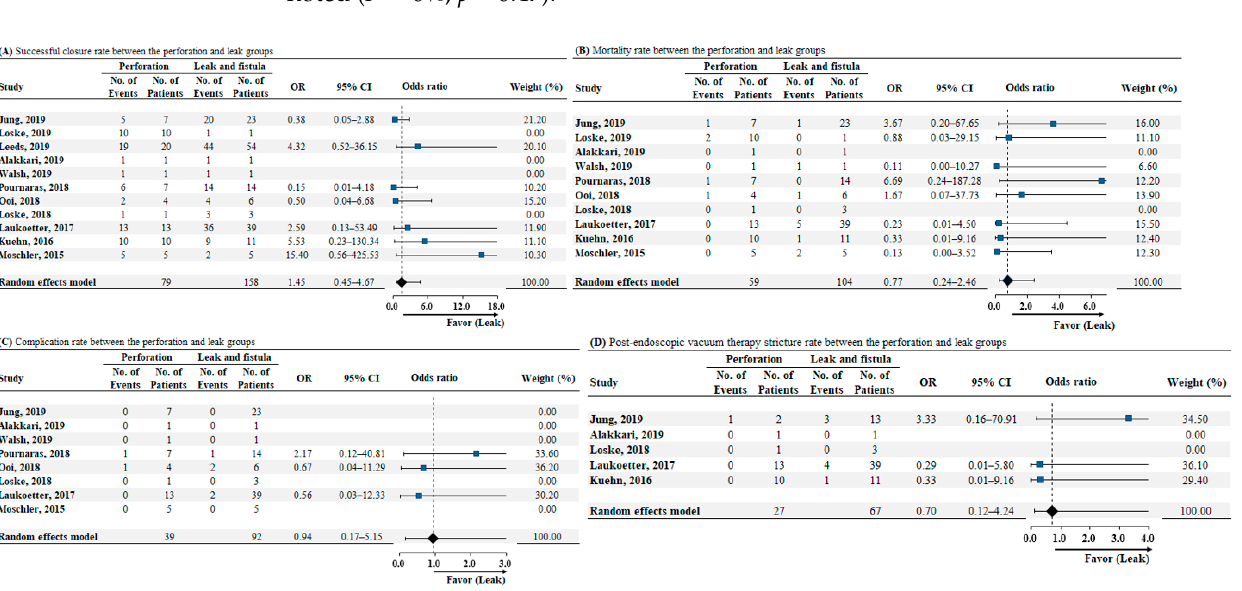
Figure 4. ( A ) Forrest plot of successful closure rate for comparison between the perforation and leak group. ( B ) Forrest plot of mortality rate for comparison between perforation and leak groups. ( C ) Forrest plot of complication rate for comparison between perforation and leak groups. ( D ) Forrest plot of postendoscopic vacuum therapy stricture rate for comparison between perforation and leak groups. Abbreviations: No, number; OR, odds ratio; CI, confidence interval.